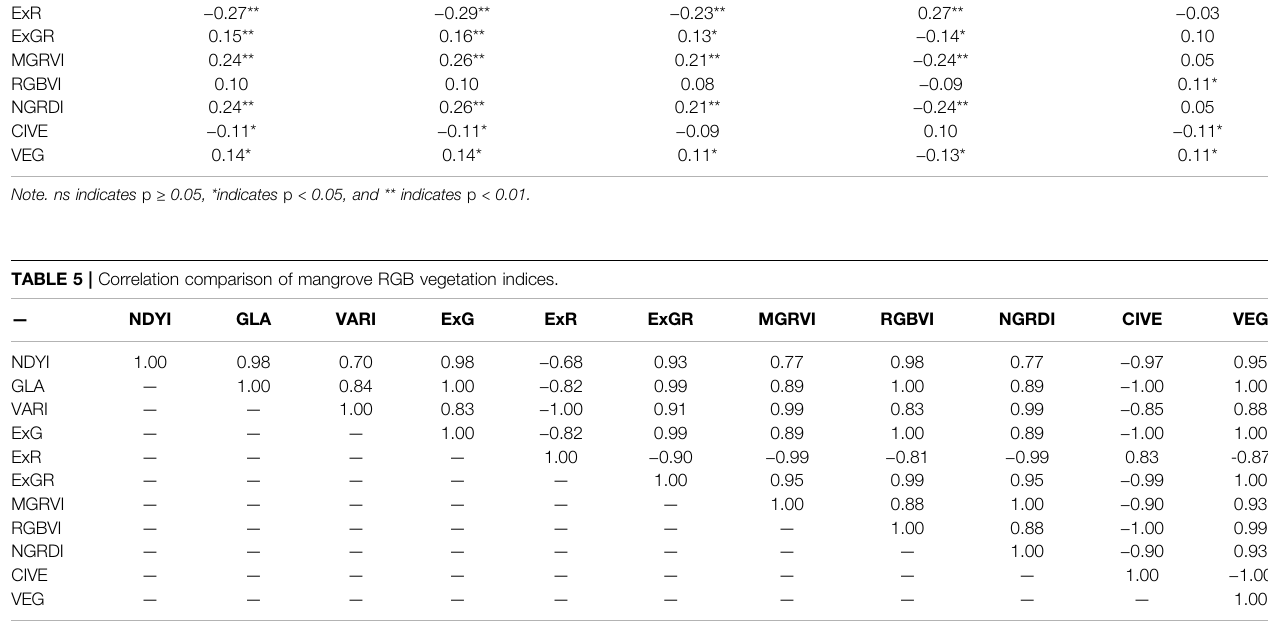
TABLE 4 | Correlation between mangrove RGB vegetation indices and meteorological factors. — Daily average Daily maximum temperature temperature NDYI